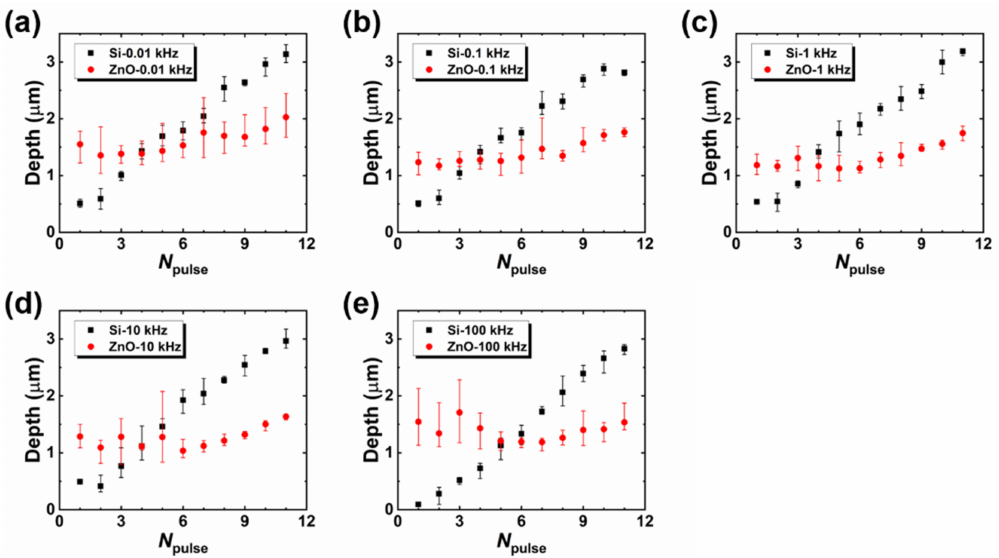
Figure 6. Depths of the multi-pulse irradiated spots of ZnO (red squares) and Si (black squares) under different repetition rates in the range 0.01–100 kHz ( a – e